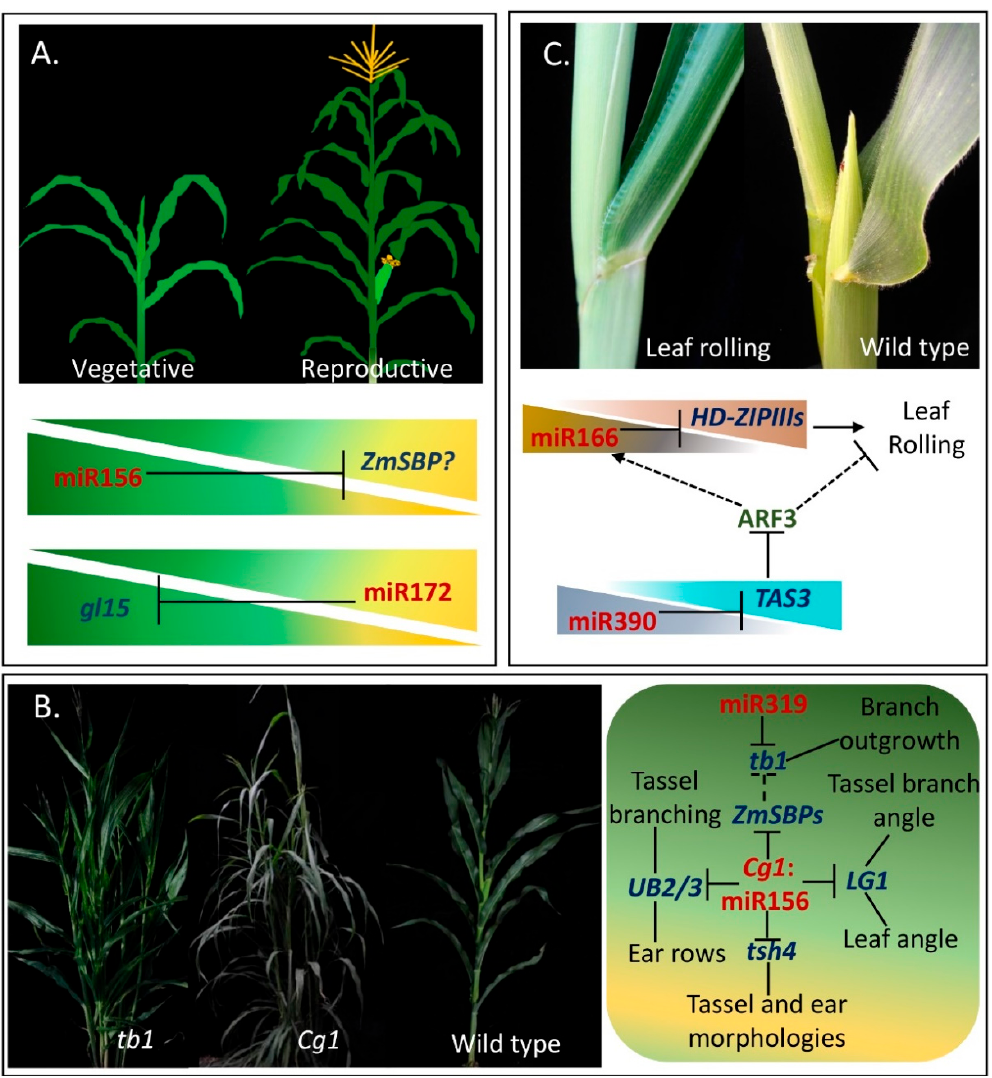
Figure 5. miRNAs or miRNA-phasiRNA interactions in agronomic traits. ( A ) Maize plant developmental timing is fine-tuned by the interaction between miR156 and miR172. However, the misslink between the two miRNAs still need to be addressed; ( B ) plant architectural modulation by the interaction of miR156 and miR319. Representative plants, tb1 (leaf), Cg1 ( middle ), and wild type ( right ) (all in the background of Chinese inbred line Zheng58) (Unpublished data), are shown. The potential ZmSBP gene probably connects the phenotype of apical dominance loss between maize mutants tb1 and Cg1. In this context, the connection between ZmSBPs and tb1 still need to be experimentally identified; ( C ) leaf shapes are being regulated by miR166 and miR390-TAS3 regulatory networks. STTMmiR166 mutants have rolling leaf phenotype ( left ), the wild type is ZZC01 ( right ). In this context, the connection between miR166 and ARF3 is still unclear.